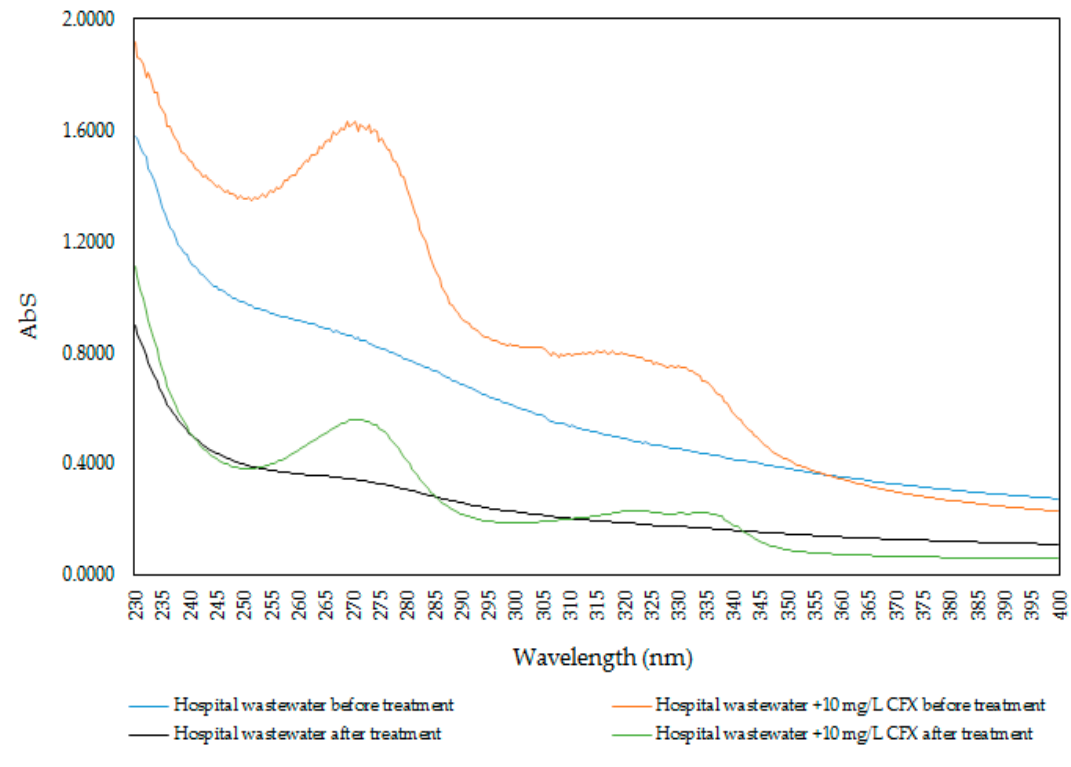
Figure 17. UV-Vis spectrum of CFX of the actual hospital wastewater samples before and after treatment using protein-modified nanosilica (ProMNS).